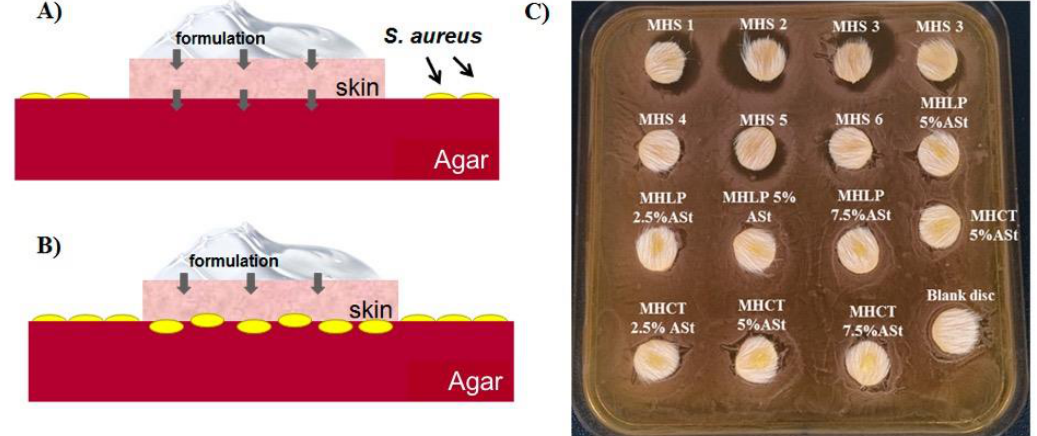
Figure 2. Skin adapted agar diffusion test cross sections. ( A )—Drug skin permeation (black arrows)